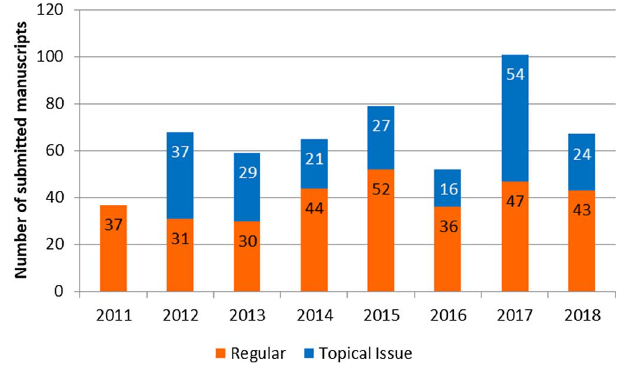
Fig. 2. Submissions to the Journal of Space weather and Space Climate.